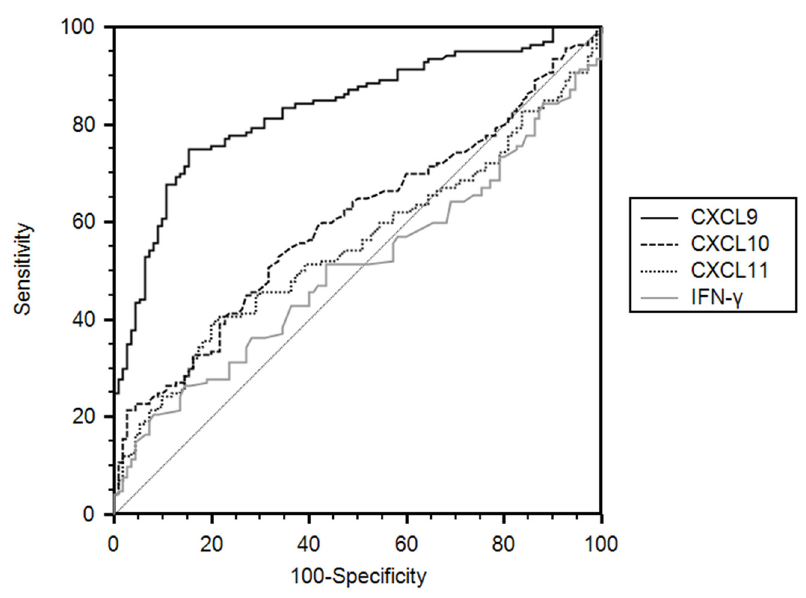
Figure 2. Receiver operating characteristics curves of interferon (IFN)- γ -inducible chemokines CXCL9, CXCL10, and CXCL11 and IFN- γ for differentiating all patients with lung cancer from the controls.